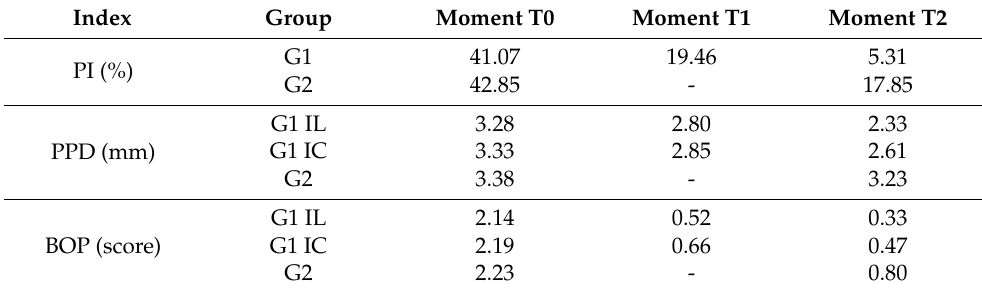
Table 1. Mean values of PI, PPD, and BOP.